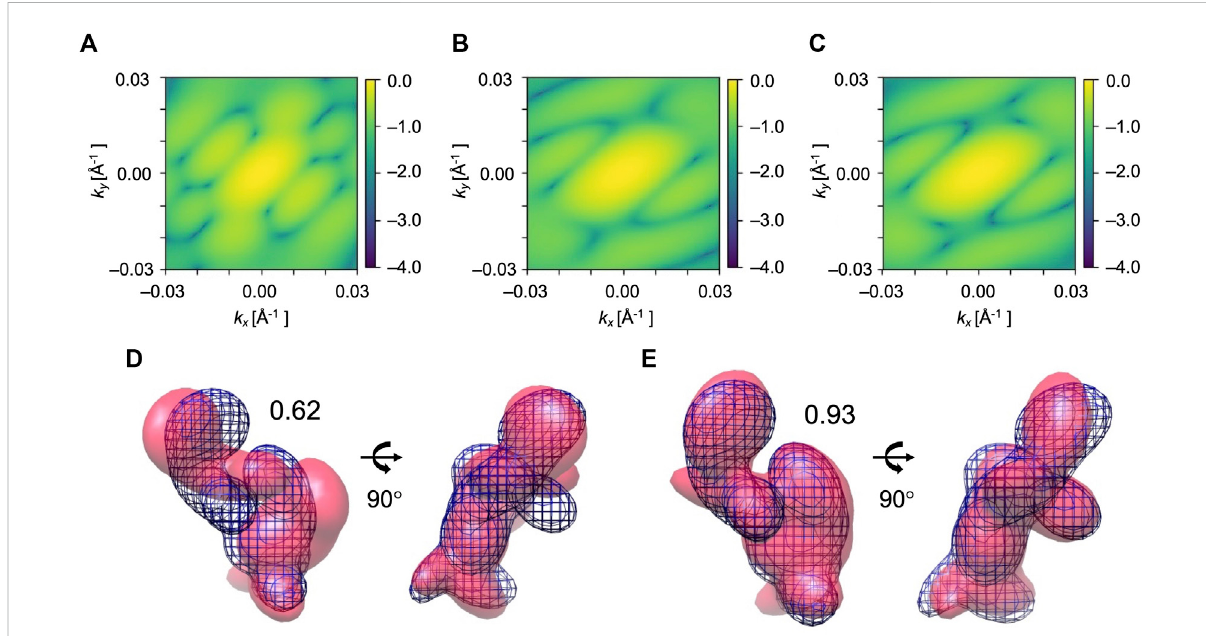
FIGURE 9 Simulated diffraction patterns from the initial (A) , candidate (B) , and target (C) GMM models from EF2 fi tting for X = 150 ° and Y = 180 ° . k x and k y represent the wavenumbers of diffraction vectors (without 2 π ). Initial 2D CC between (A) and (C) was 0.05, which increased to 0.98 between the (B) and (C) after the MC simulation process. GMM representations of EF2 before and after the fi tting for X = 150 ° and Y = 180 ° are shown. (D) The initial modelisinpink,thereferenceGMMrepresentationofthetargetmodelisinbluemesh.Initial3DCCbetweentheinitialmodelandtargetis0.62. (E) The candidate model is in pink, the reference GMM representation of the target model is in blue mesh. The fi nal 3D CC between the candidate model and the target is